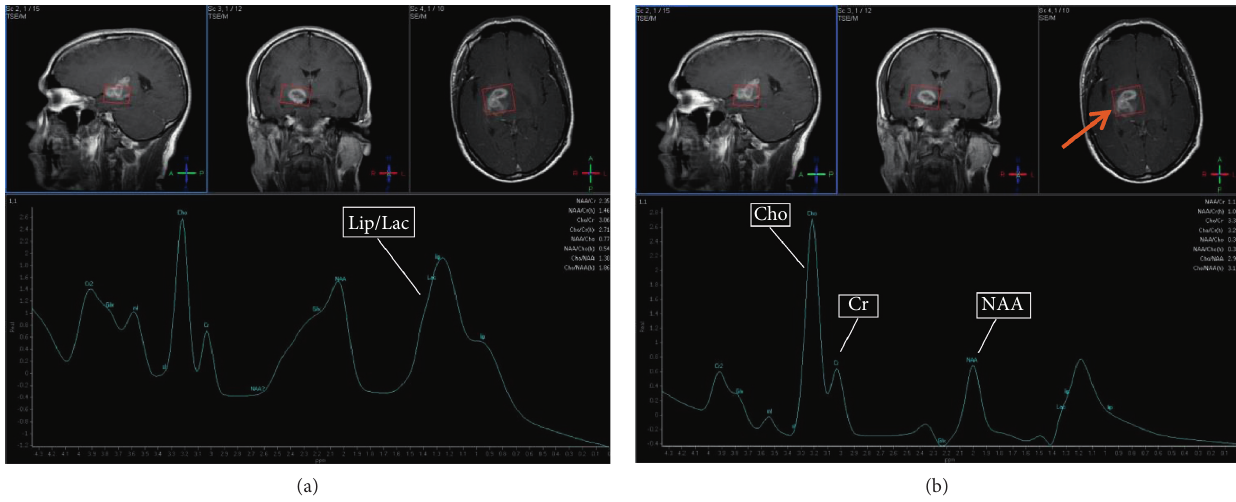
Figure 9: (a) TE 31 msec. (b) TE 144 msec. MRS was performed to differentiate between high-grade glioma and tuberculoma. The lesion was diagnosed as a high-grade glioma. NAA is depressed. Lipid is elevated. Choline is markedly elevated. Cho: Cr is 3.28, and Cho :NAA is 3.17. Note that in this case diagnosed as high0grade glioma, myo-inositol at TE31 is not